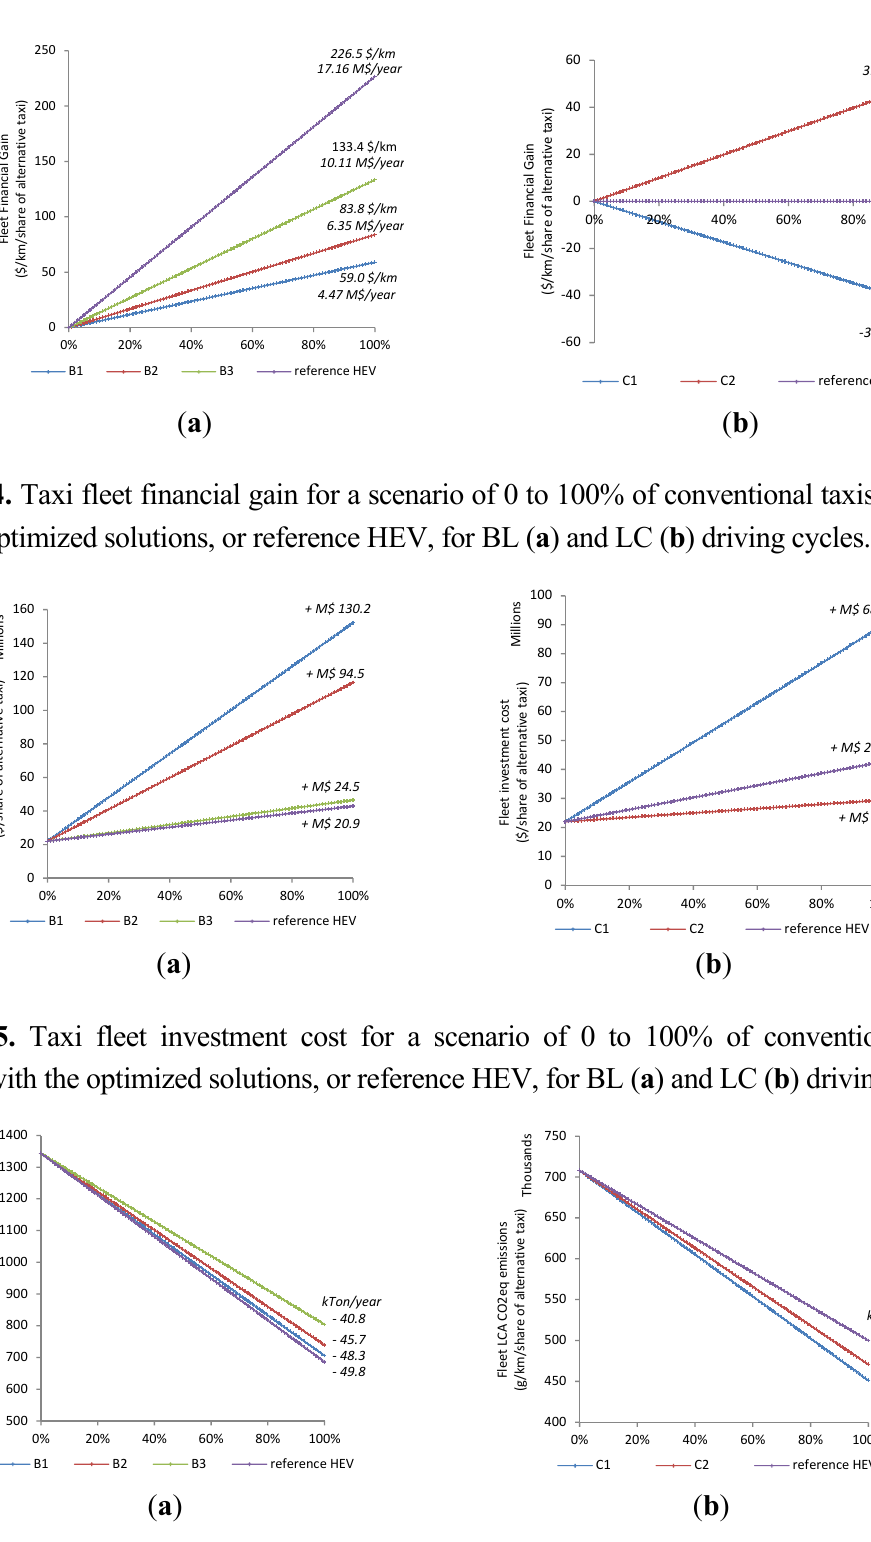
Figure 16. Taxi fleet LCA CO 2eq emissions for a scenario of 0 to 100% of conventional taxis replaced with the optimized solutions, or reference HEV, for BL ( a ) and LC ( b ) driving